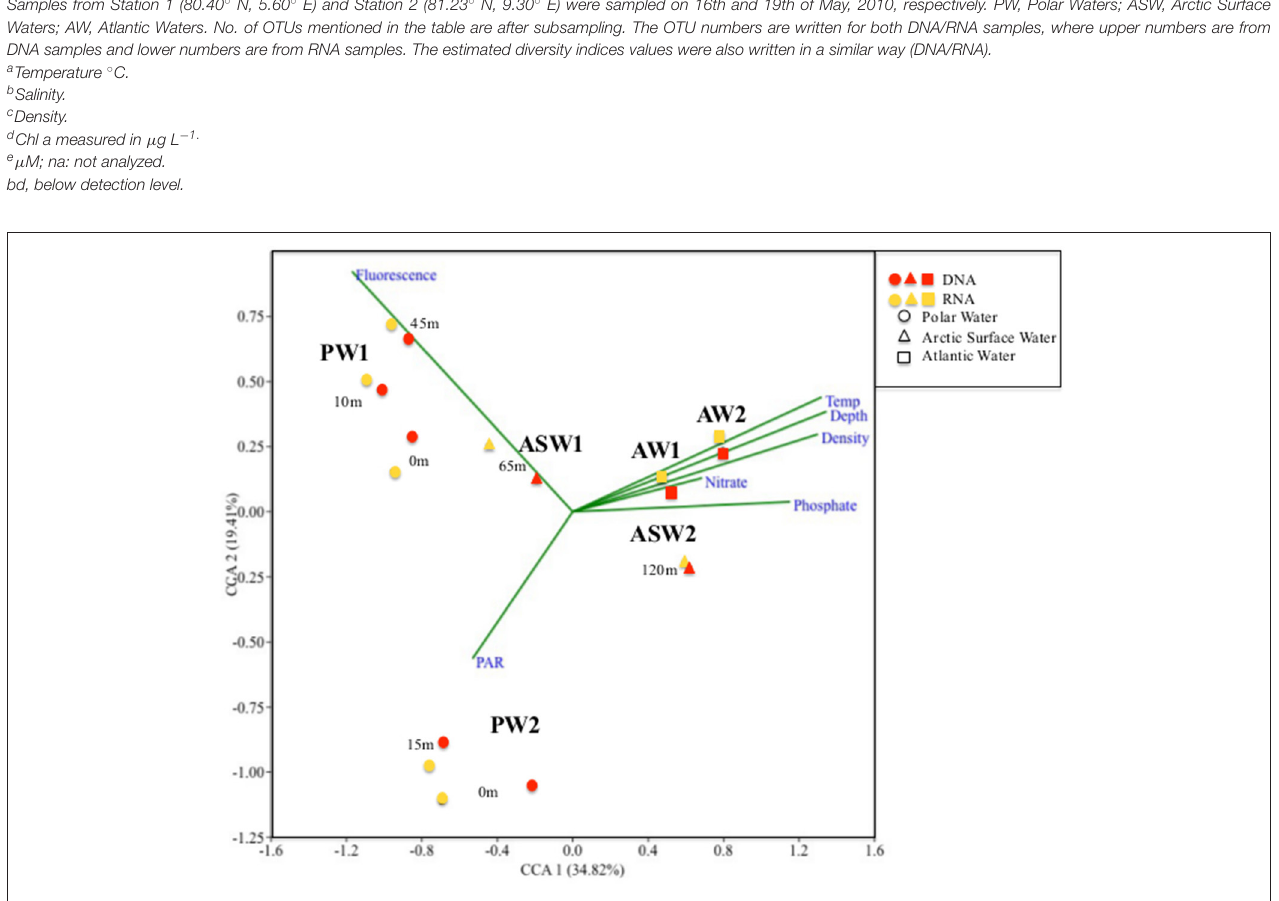
( Figure 6 ). An OTU assigned to the rhizarian Cryomonadida (OTU 20) was highly abundant in the surface DNA library from Station 1. Other abundant taxa in the deep AW included two OTUs assigned to the radiolarian Taxopodida B ( Table 2 , Figures 5 , 6